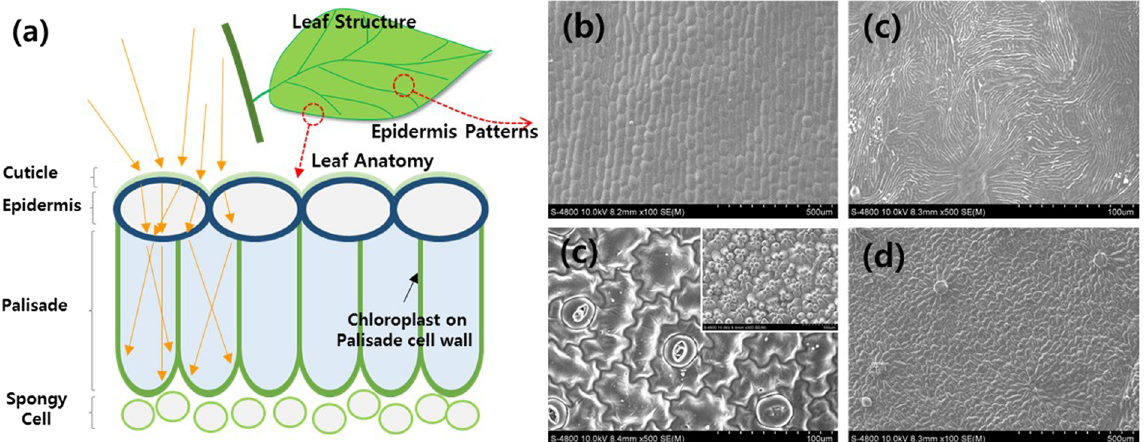
Figure 1. Schematic diagram of the anatomy of a leaf structure. Scanning electron microscopy (SEM) images of the surfaces of leafs from ( b ) Polygonatum odoratum , ( c ) Lagerstroemia indica , ( d ) Zinnia elegans (inset: petal), and ( e ) Solanum melongena